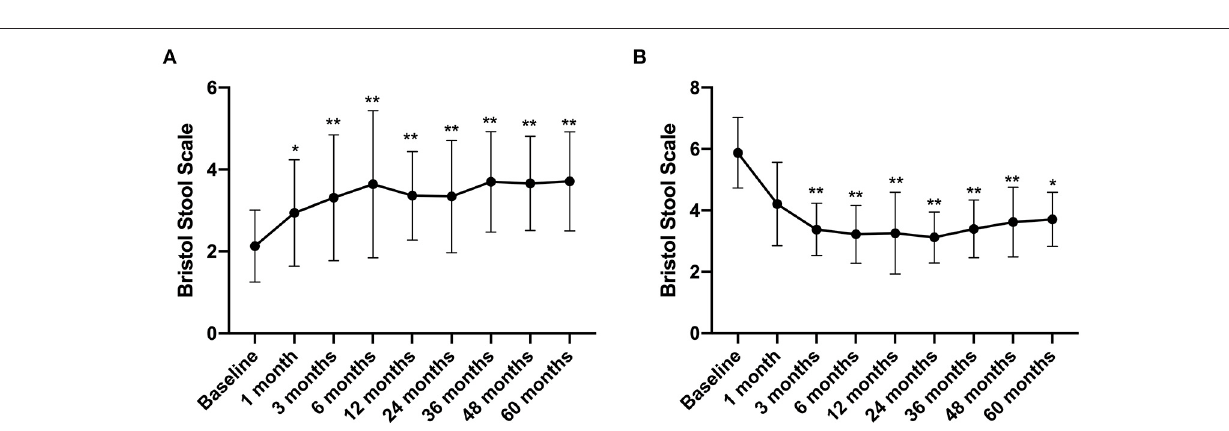
FIGURE 6 | Bristol Stool Scale between groups and their change over time. Difference was compared between each time point of follow-up and before FMT (baseline). (A) IBS-C; (B) IBS-D. Data are presented as x ± s, statistical analyses: univariate analysis of variance, * p < 0.05, ** p <